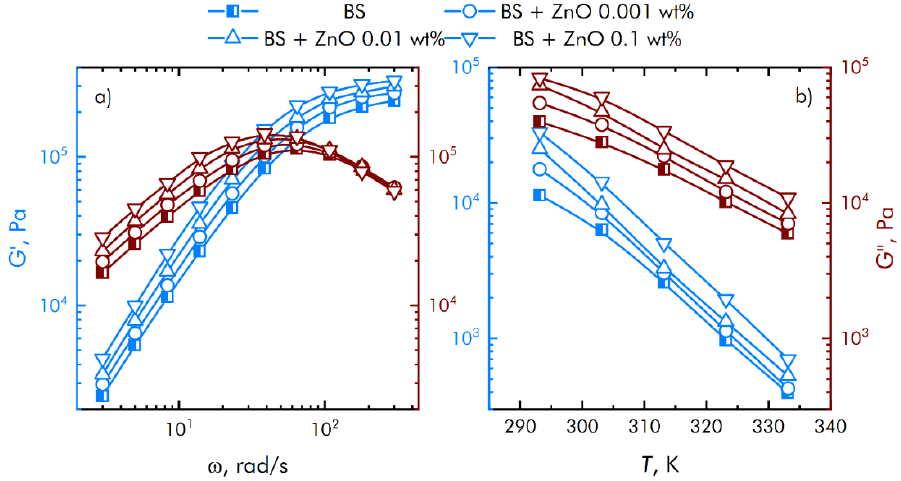
Figure 4. Influence of composite material based on boroxiloxane and zinc oxide nanoparticles on the mechanical spectra; storage modulus—blue symbol, loss modulus—red symbol. ( a ) The dependence of the change in the mechanical spectra of composites on the rotation speed. ( b ) Temperature dependence of the change in the mechanical spectra of